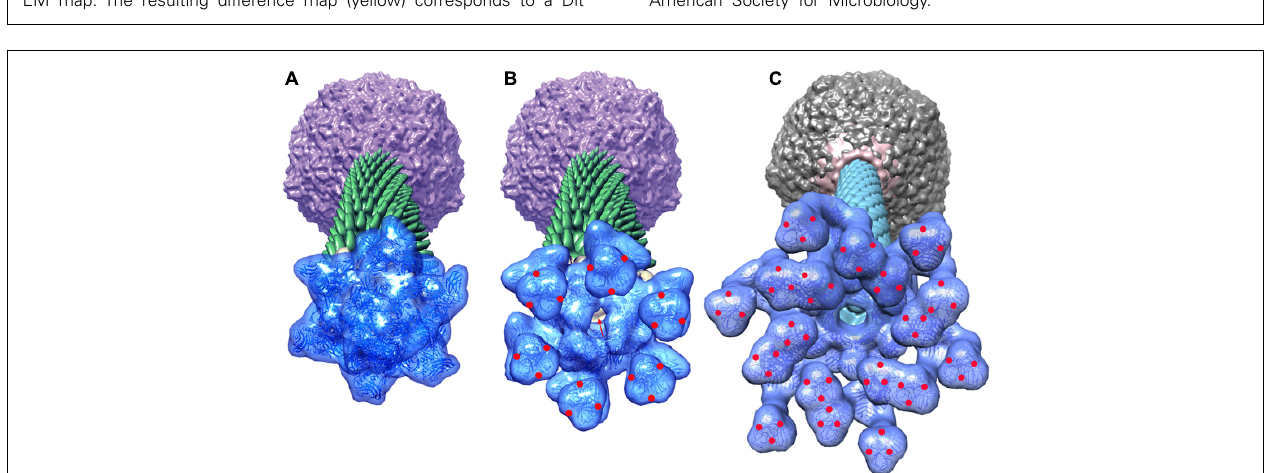
FIGURE 9 | Perspective views of the reconstructions of the p2 phage. (A) The baseplate rest form and (B) the Ca ++ activated form, showing in forefront the baseplate structure, closed and opened, respectively. (C) The TP901-1 baseplate. The red dots are located at the RBP saccharides